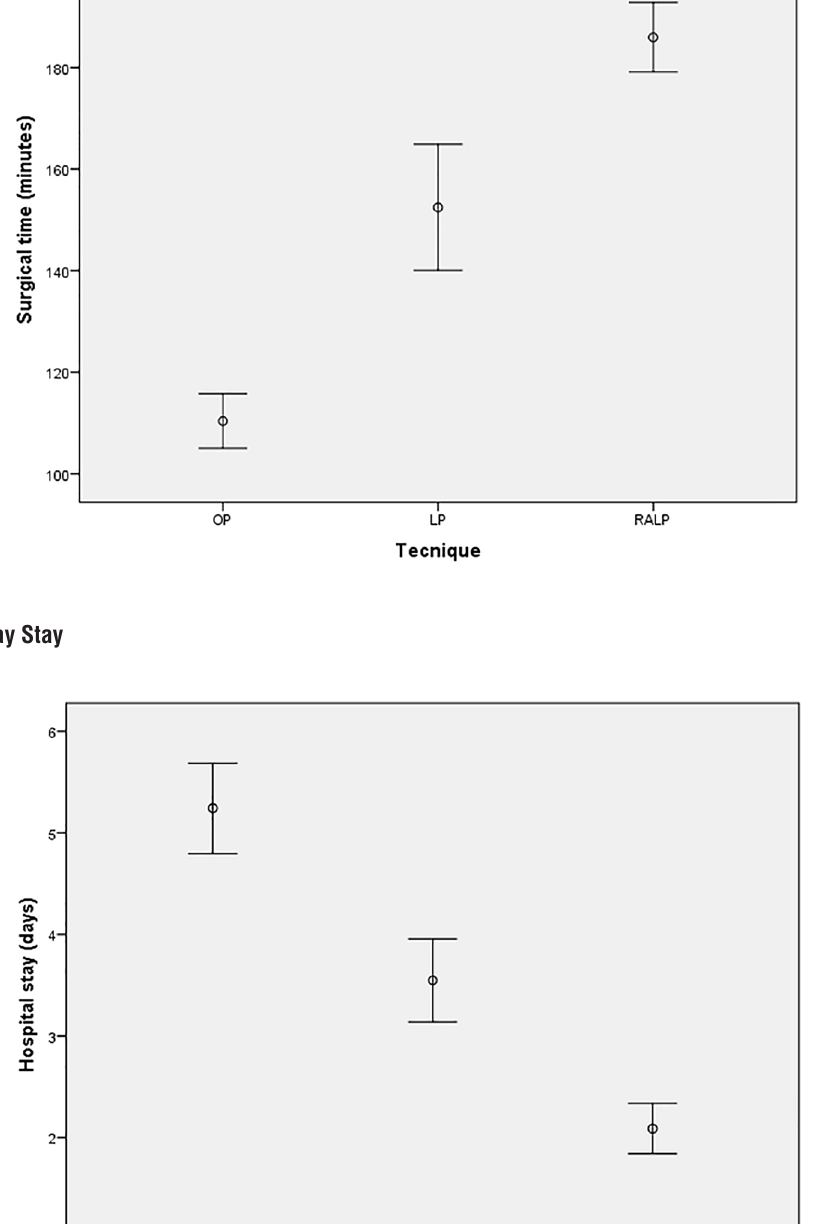
Figure 1 - Comparison of surgical time and hospital stay in open, laparoscopic and robotic pyeloplasty. Figure 1A. Surgical Time.